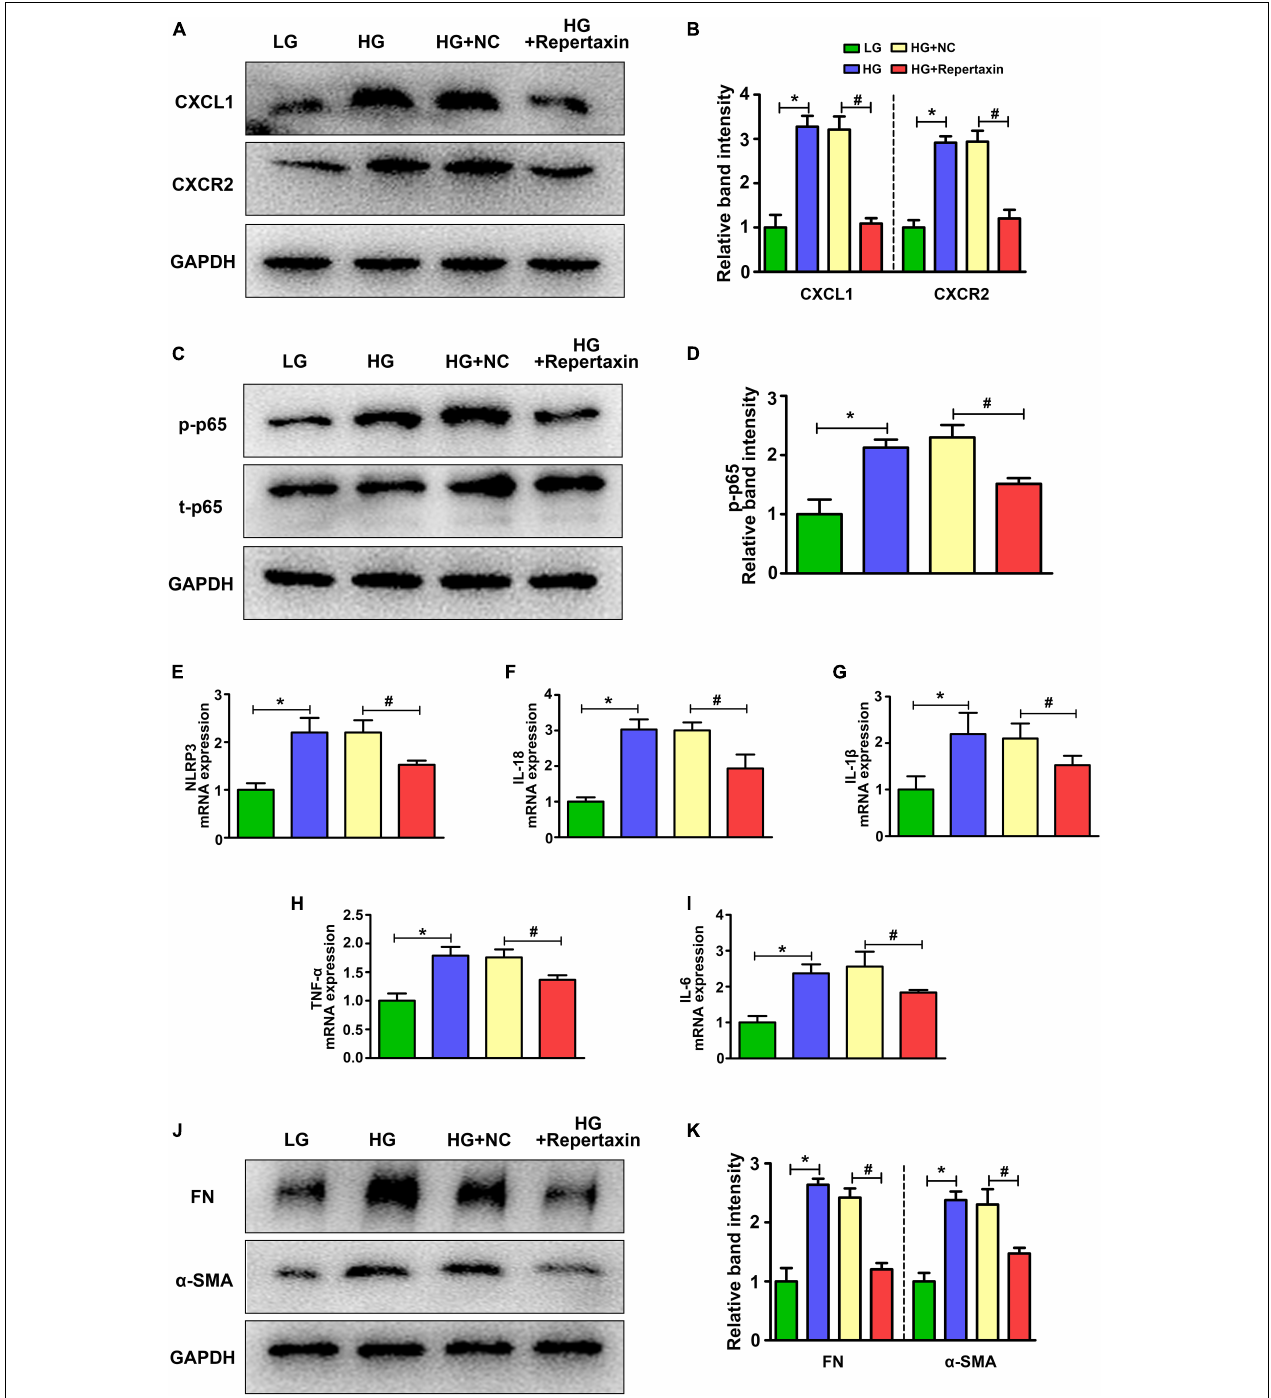
FIGURE 4 | Altered CXCL1/CXCR2 expression and the activated inflammatory response in HK-2 cells treated with HG. (A,B) The expression of CXCL1 and CXCR2 in HK-2 cells with different interventions. (C,D) Changes in phosphorylated p65 levels in HK-2 cells with different interventions. The mRNA levels of NLRP3 (E) , IL-18 (F) , IL-1 β (G) , TNF- α (H) and IL-6 (I) in HK-2 cells. (J,K) The expression of FN and α -SMA in HK-2 cells with different interventions. The values are the mean ± SD. n = 6/group. * p < 0.05 compared with the LG group; # p < 0.05 compared with the HG + NC group. LG, low glucose; HG, high glucose; HG + NC, high glucose and DMSO; FN, fibronectin; α -SMA, α -smooth muscle actin.